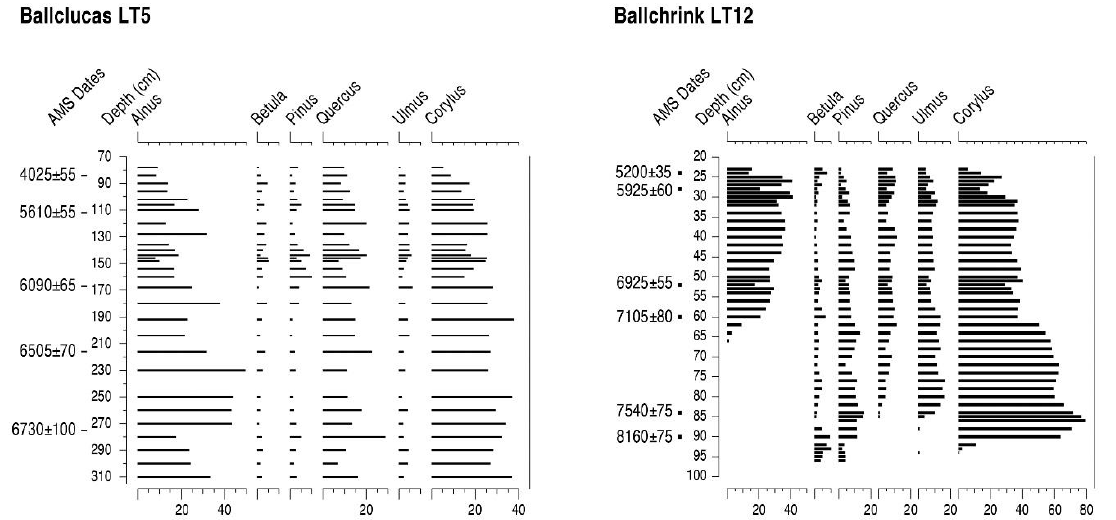
Figure 4. Percentage pollen diagrams from Ballaclucas LT5 and Ballachrink LT12, Isle of Man, showing selected tree taxa and 14 C BP AMS ages.